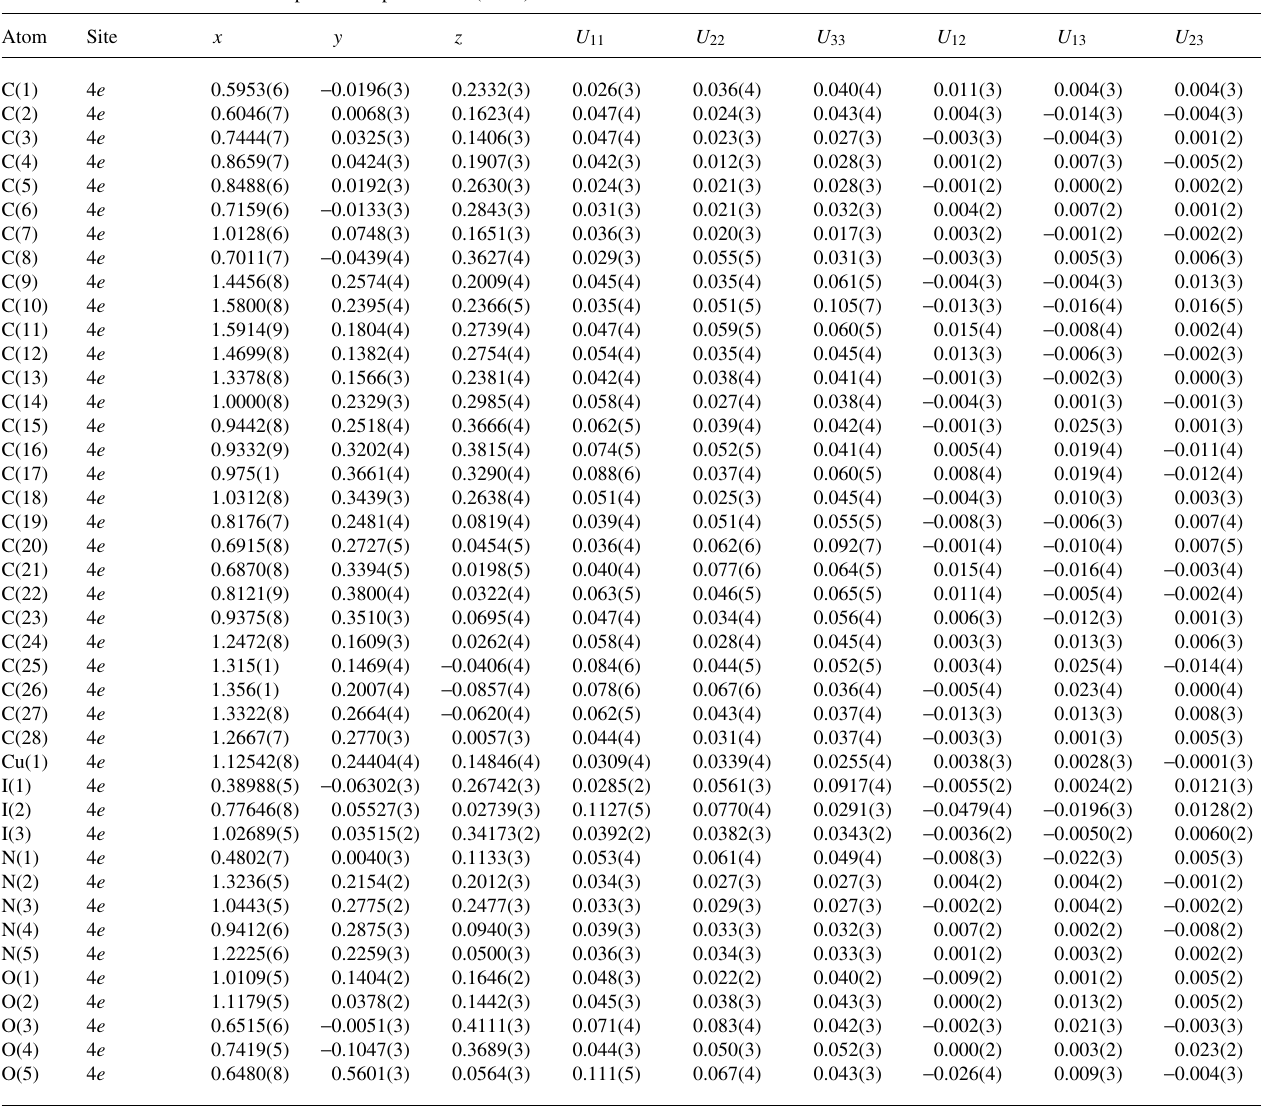
Table 3. Atomic coordinates and displacement parameters (in Å 2 ) .